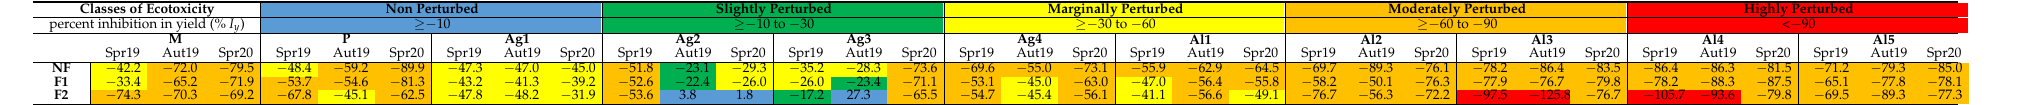
Table 2. Classes of disturbances, purposed ranges of ecotoxicological potential and ecotoxicity results for R. subcapitata assays after exposure to natural water treatments treatments (NF—Non-filtered water; F1 and F2—filtered with 1.2 µ m and 0.22 µ m respectively). Values represent the percent inhibition in yield (% Iy ), comparatively to the control. Sampling points: Miranda—M,